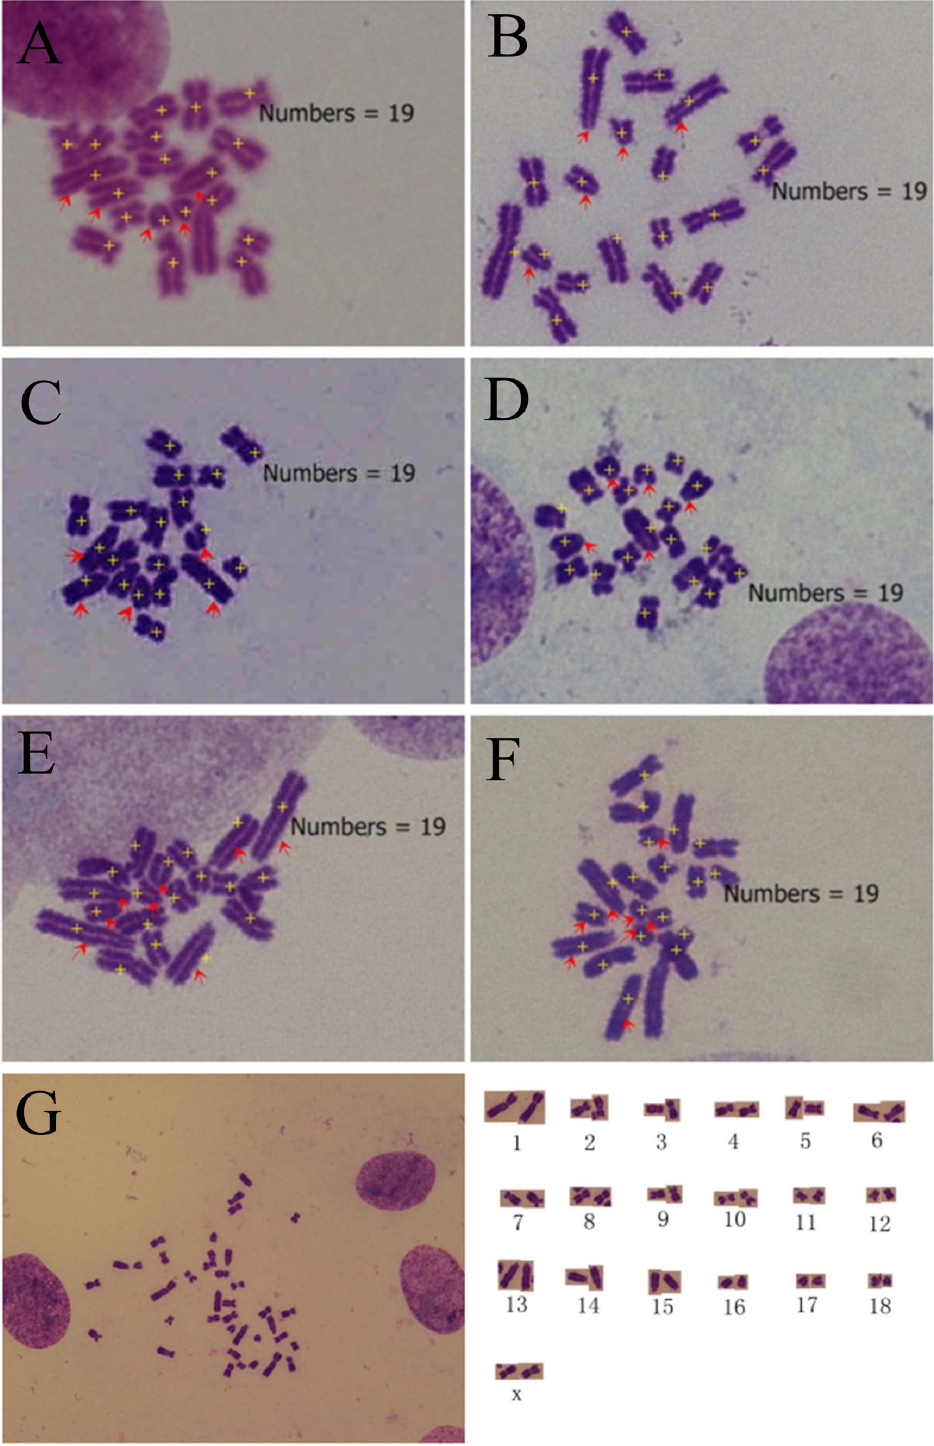
Figure 5. The chromosome spread of PA embryo-derived fibroblasts. (A–D) Haploid PA cells with an abnormal chromosome spread lack one telocentric chromosome. (E and F) The haploid cells with other kinds of abnormal chromosome spread. The red arrow indicates a telocentric chromosome. (G) The diploid cell with normal karyotype. doi:10.1371/journal.pone.0097974.g005 mented with 0.5% pronase to remove the zona pellucida. water supplemented with 0.075 M KCl, 0.1% PVA) at 37 u C for Individual blastomeres were dissected in DPBS containing 0.1% 20 min, followed by treatment in pre-fixation solution (3:1:2, PVA. Blastomeres were incubated in hypotonic solution (distilled methanol:acetic acid:DPBS with 0.1% PVA) for 3 min. Pre-fixed